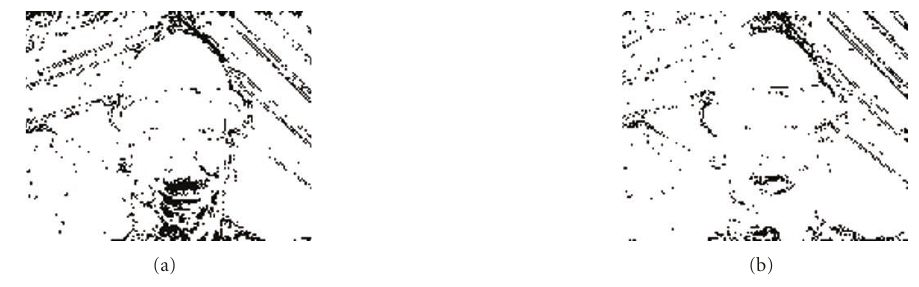
Figure 10: The unobservable pixels of frame 22 (a) and frame 25 (b) in the nonsynthetic “Foreman” experiment.